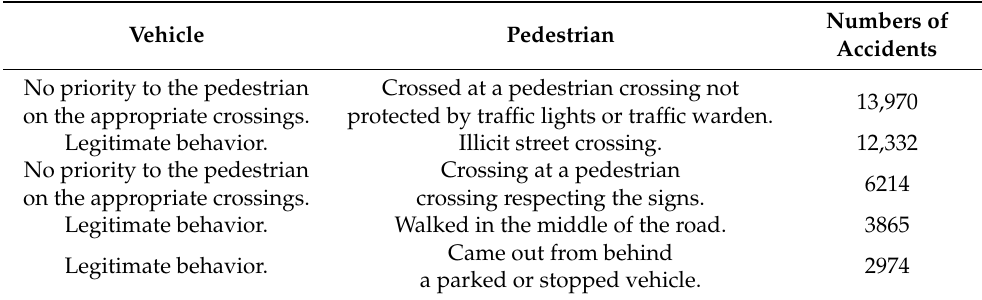
Table 1. Top five driver–pedestrian interactions.